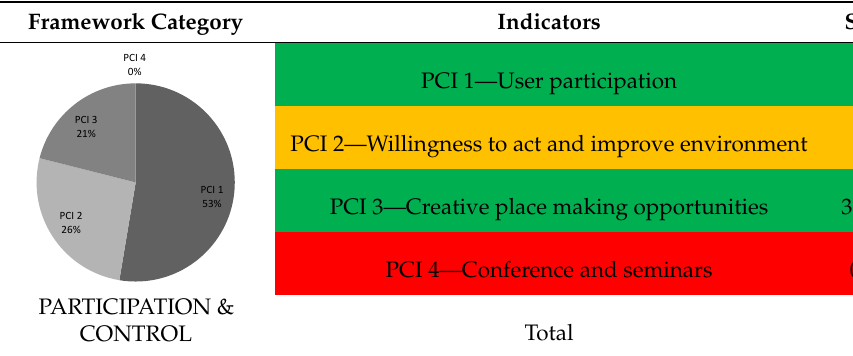
Table 10. RAG rating of Participation & Control Indicator in Louroujina.